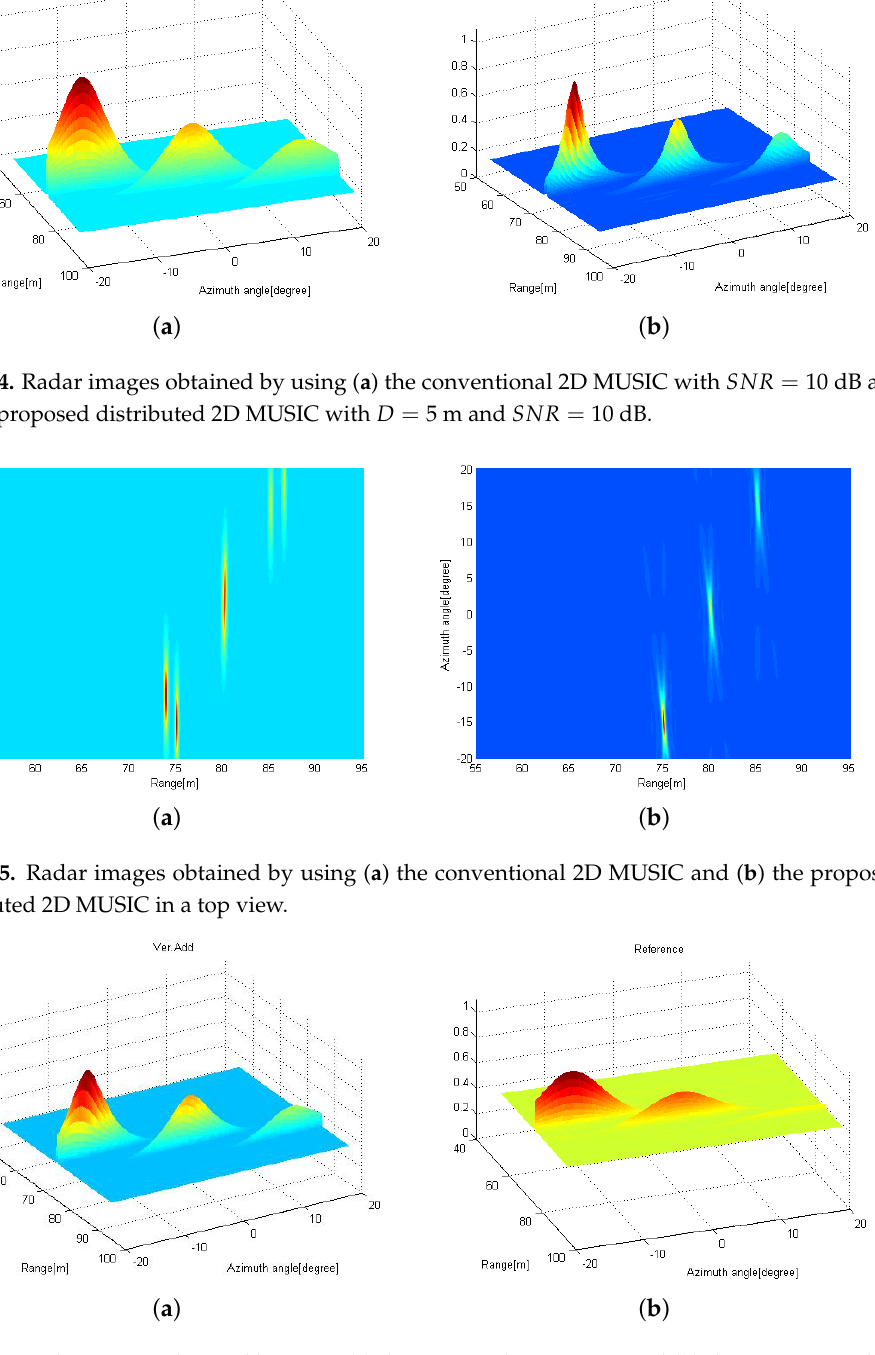
Figure 6. Radar images obtained by using ( a ) the proposed 2D MUSIC and ( b ) the conventional 2D MUSIC when SNR= { 10,6.6 } dB at two different